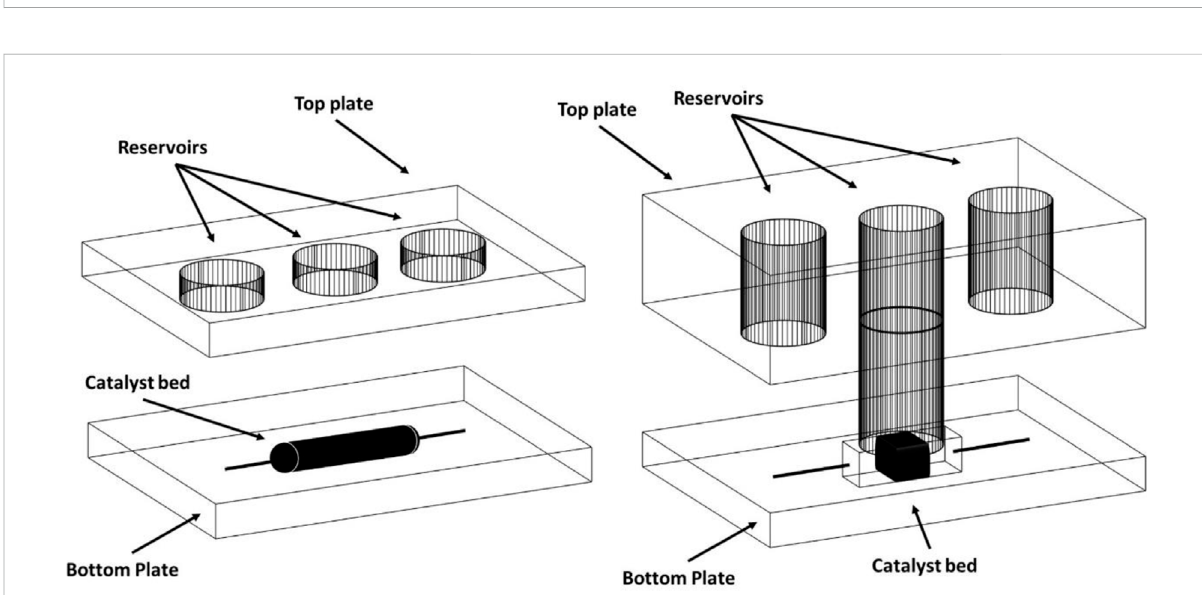
FIGURE 16 Microreactor employed in Suzuki – Miyaura couplings (He et al., 2004). Reproduced with permission of Royal Society of